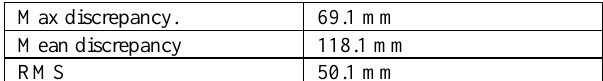
Table 5 - Comparison between the point cloud from LIDAR data and the point cloud produced by PhotoScan. Cloud Compare processing.